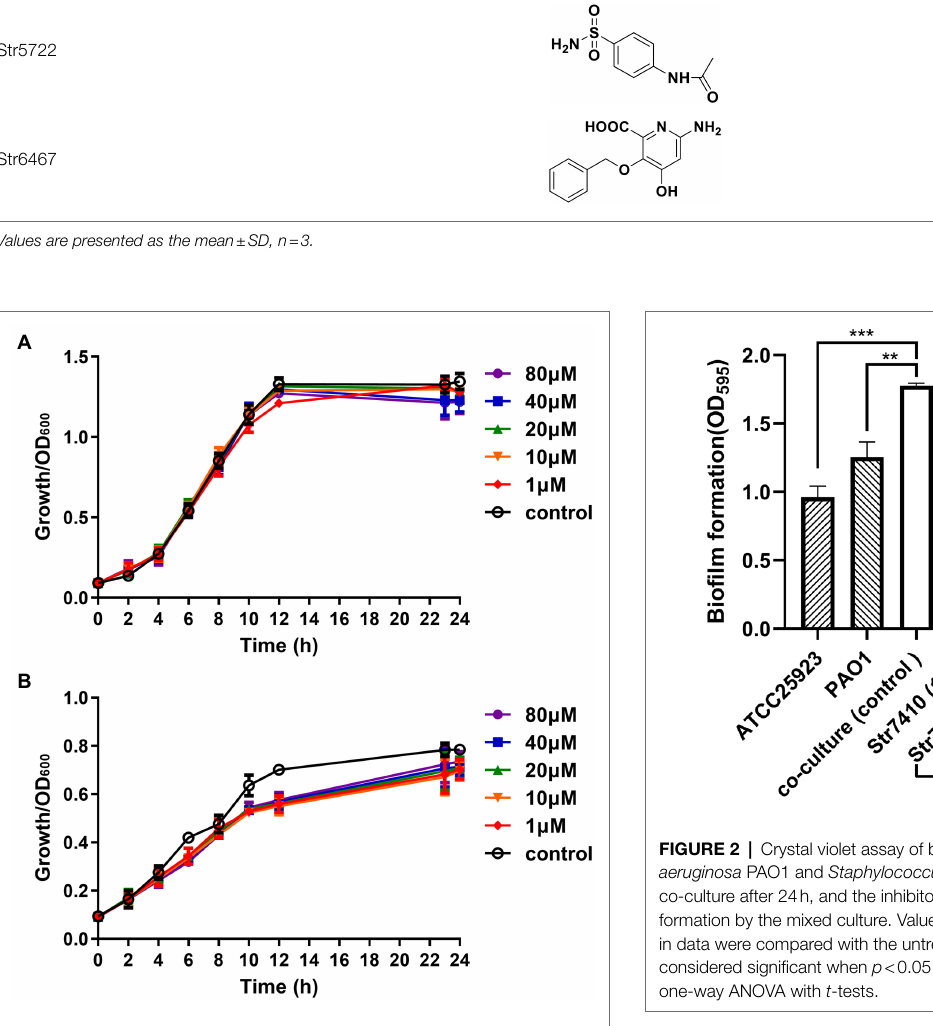
FIGURE 1 | Effect of compound Str7410 (1–80 μ M) on the growth of Pseudomonas aeruginosa PAO1 and Staphylococcus aureus ATCC 25923. (A) Pseudomonas aeruginosa PAO1 growth curves. (B) Staphylococcus aureus ATCC 25923 growth curves. Values are presented as the mean ±